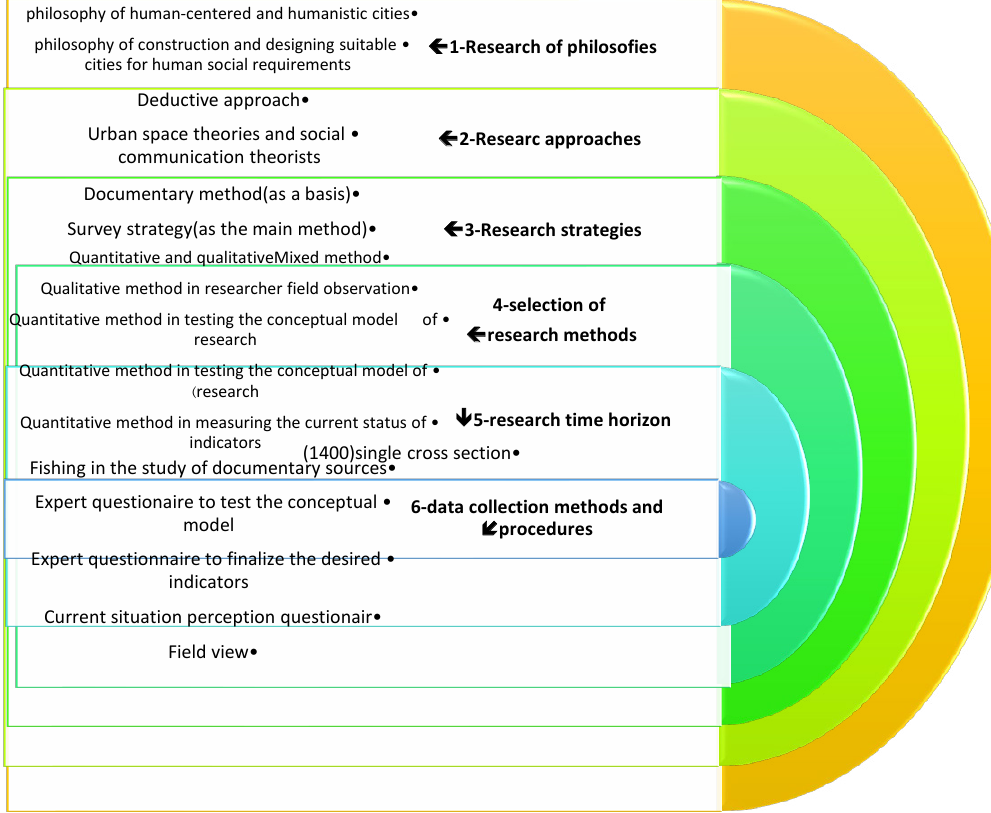
Fig. 1: Layers of research system or research onion explain the role of urban pause space in promoting interactions